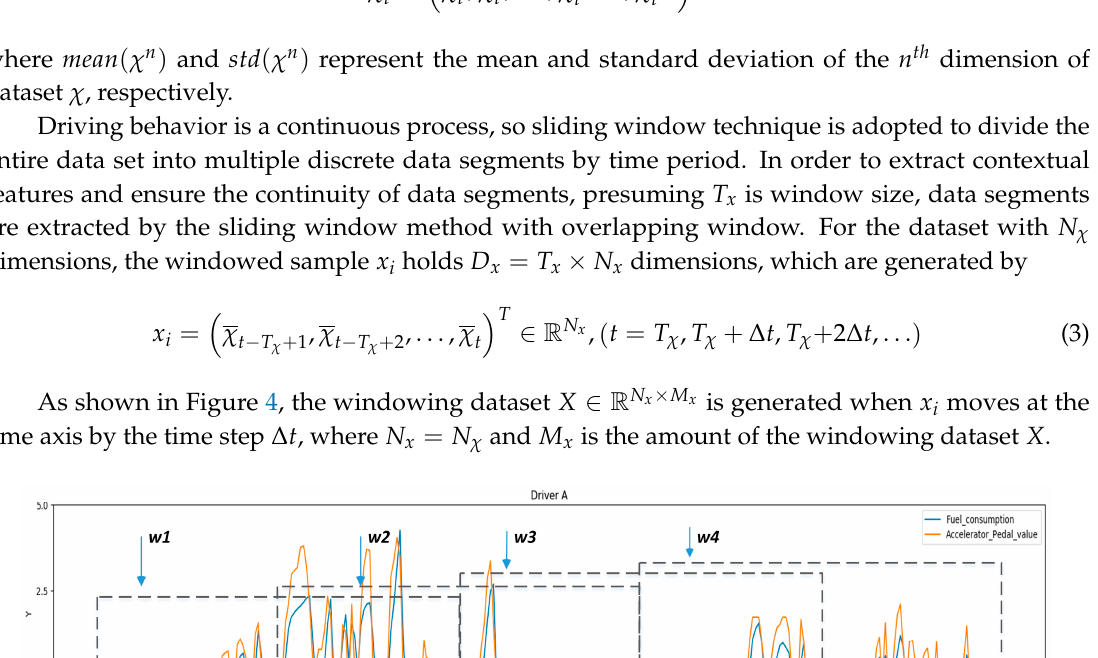
w , w , w , w ) were obtained from the 1 2 3 4 T to 120 samples and time step t Δ to 60 samples. x